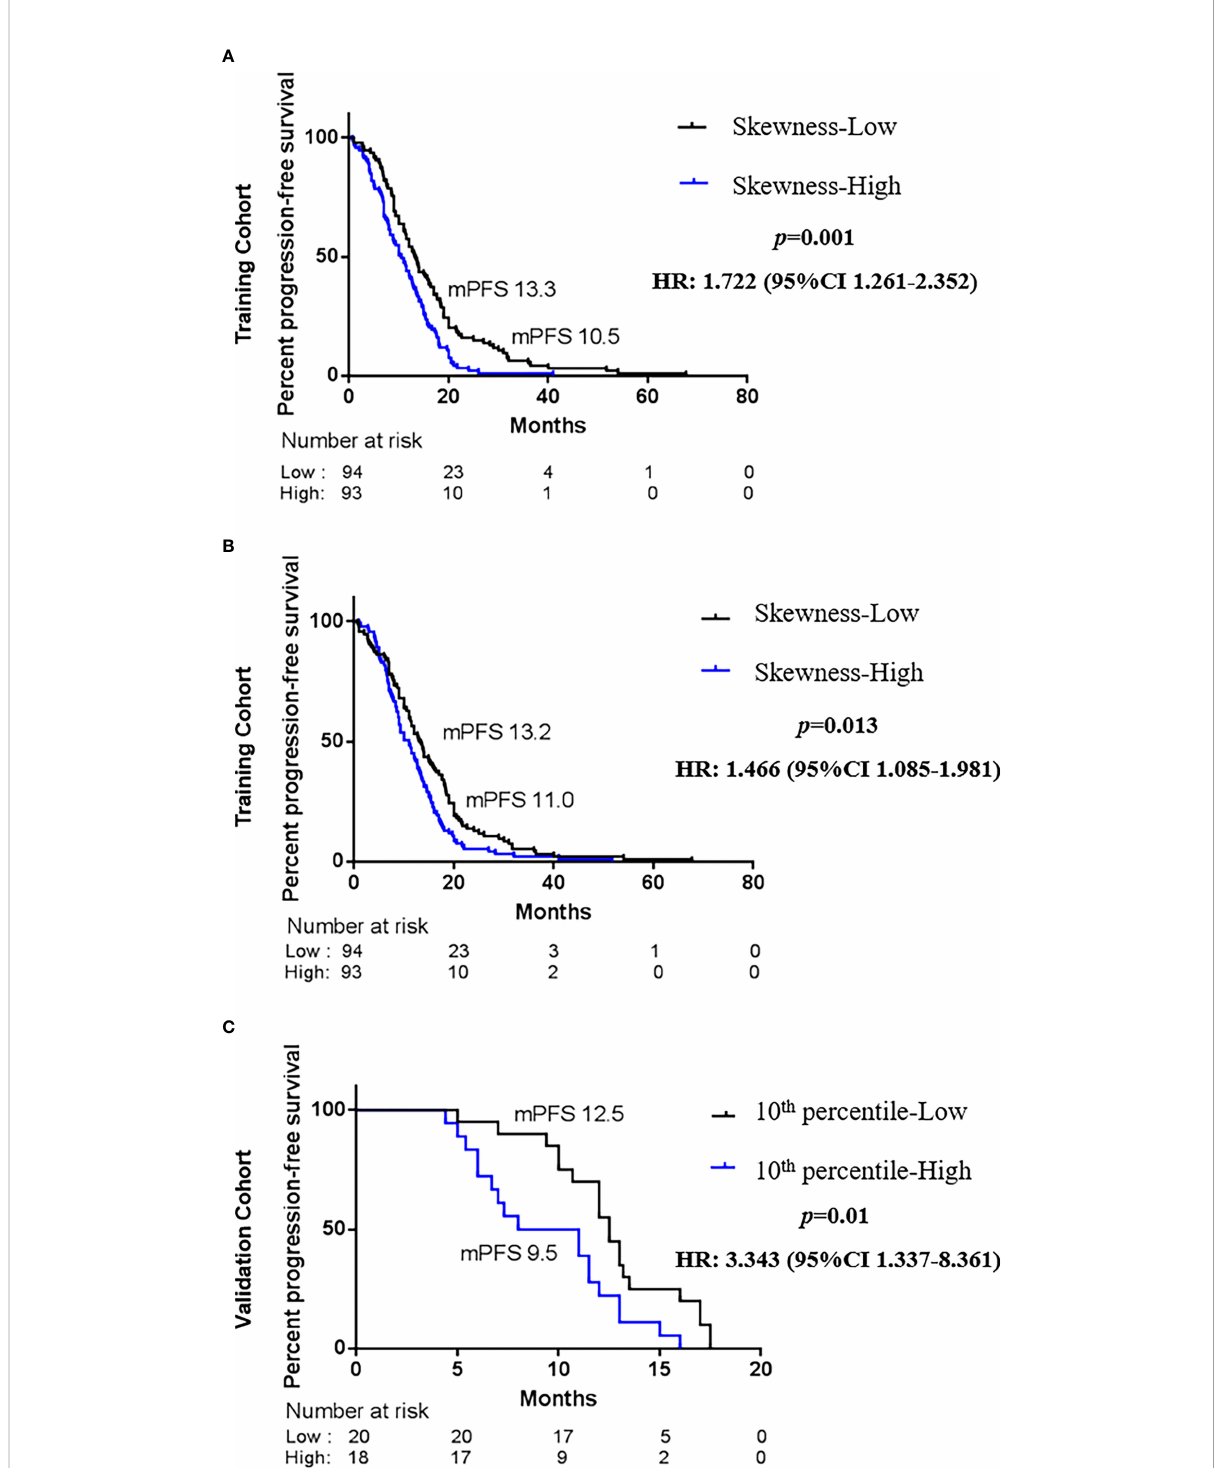
FIGURE 4 Kaplan – Maier survival curves of progression-free survival under biomarker-de fi ned subgroups. In the tyrosine kinase inhibitor (TKI) therapy training cohort, (A) strati fi cation by the skewness of fi rst-order category (low ≤ 0.882 versus high > 0.882); (B) strati fi cation by the 10th percentile of fi rst-order category (low ≤ 21.132 versus high > 21.132). In the TKI therapy validation cohort, (C) strati fi cation by the skewness of fi rst-order category (low ≤ 0.882 versus high > 0.882). p -Values are calculated with multivariate Cox models adjusted by age, gender, smoking history, family history, TNM stage, and tumor